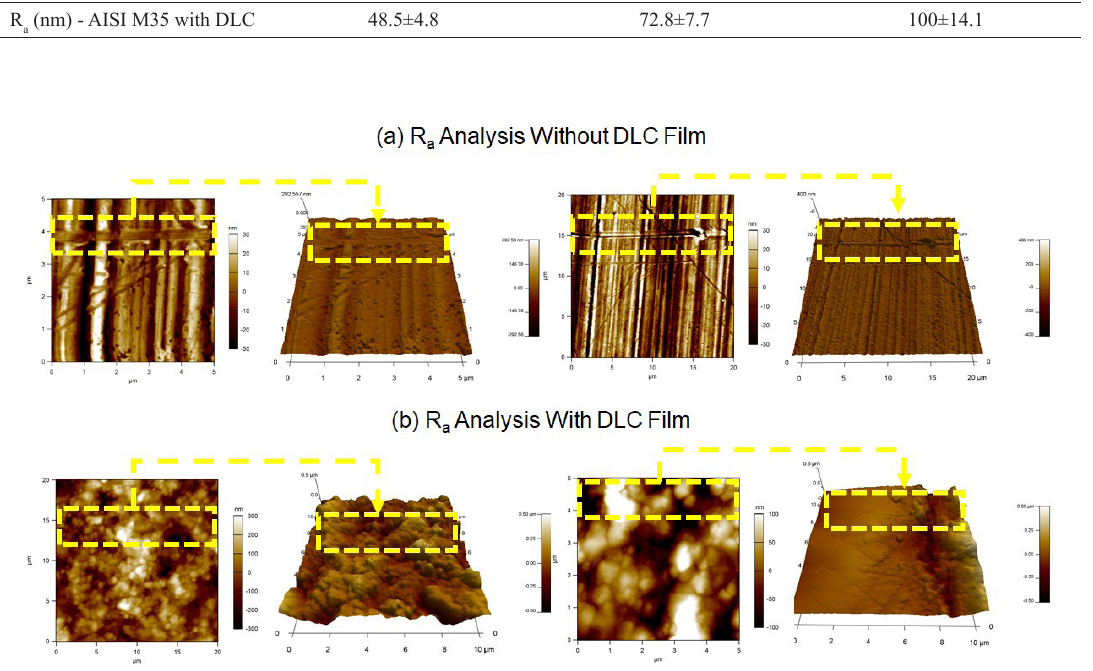
Table 4. Average surface roughness R